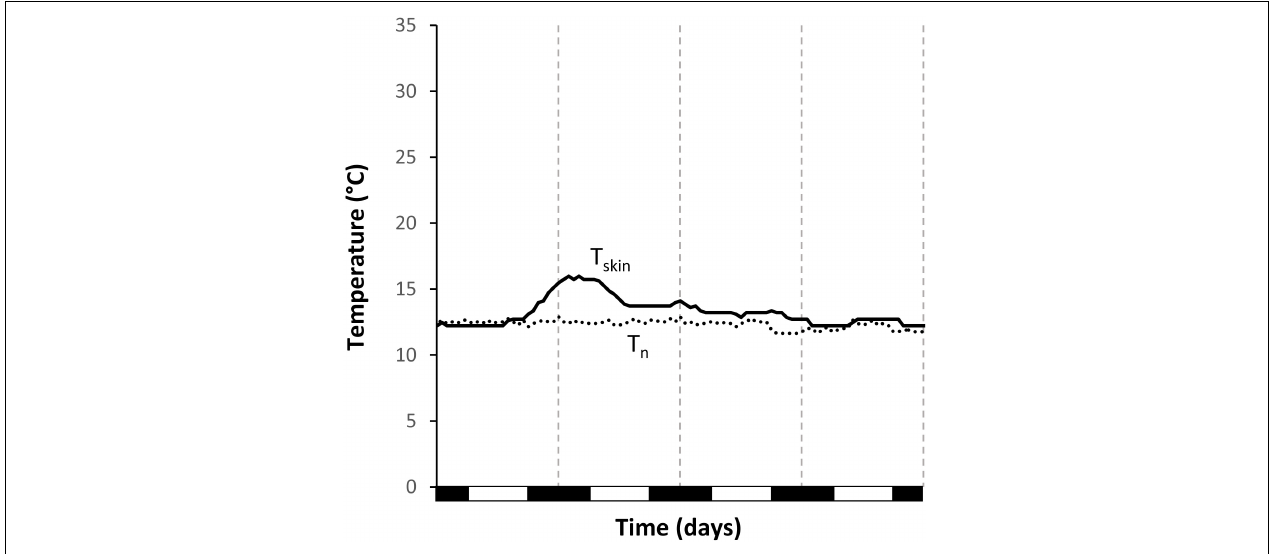
FIGURE 4 | Unsuccessful attempt at rewarming from torpor of Echinops telfairi under constant temperature treatment in winter (W const12 ). During this event, skin temperature reached a maximum of only 14.7 ◦ C and only slowly returned to the level of nest box temperature over two days. Black line: skin temperature; dotted line: nest box temperature; vertical dashed lines indicate midnight, black boxes on the x-axis the